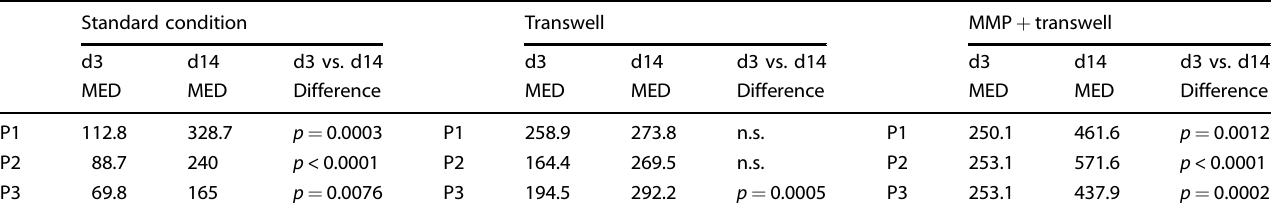
Table 1. Cell counts for each scaffold type and recellularization strategy used at respective time point after recellularization, including the calculated differences in p -value between relevant comparisons. Standard